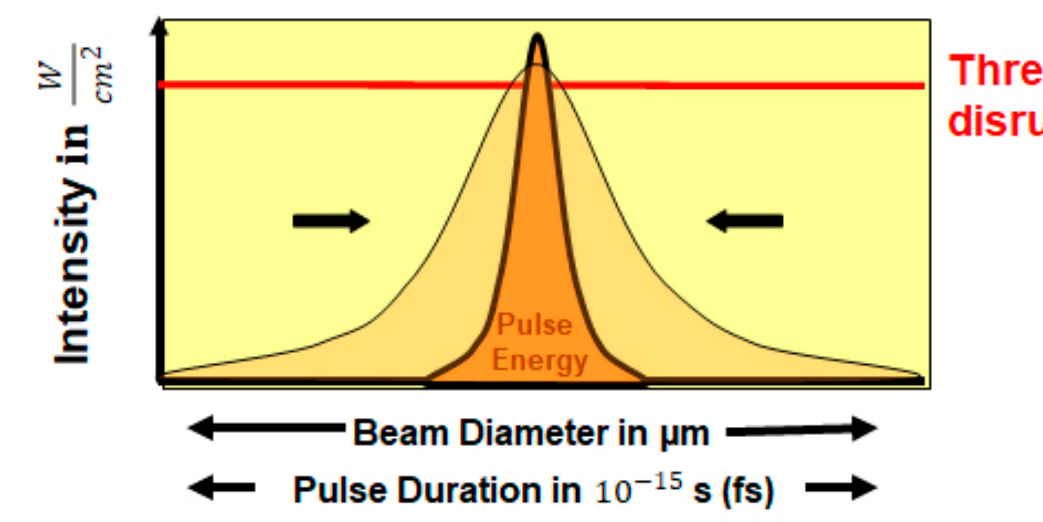
Figure 1. By shortening the pulse duration, the pulse energy to reach threshold intensity is reduced and thus the potential side effects are also reduced. The intensity is defined with W ( J